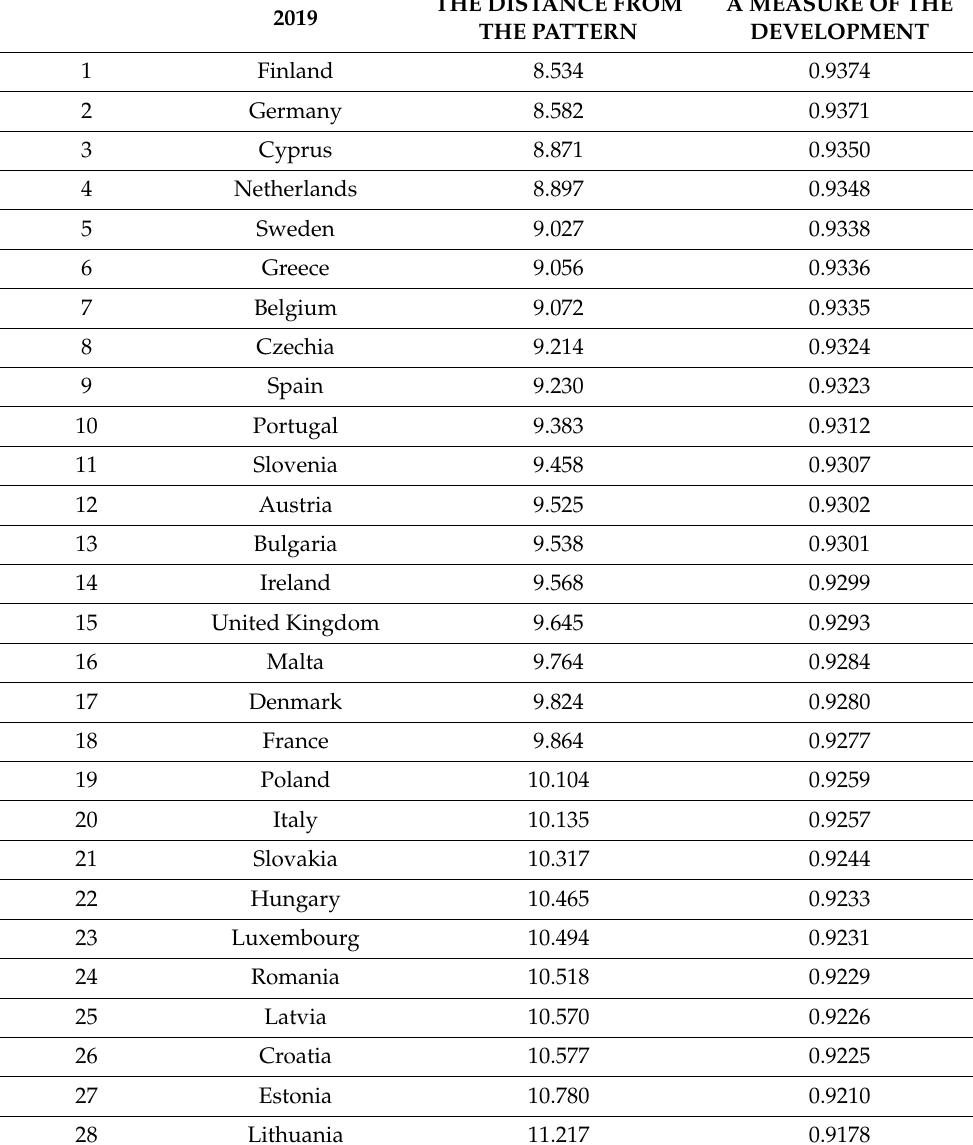
Table 3. The results of the linear order—the distance of objects from the development pattern and a measure of the development for energy production per capita in the European Union countries in 2019. THE DISTANCE FROM THE